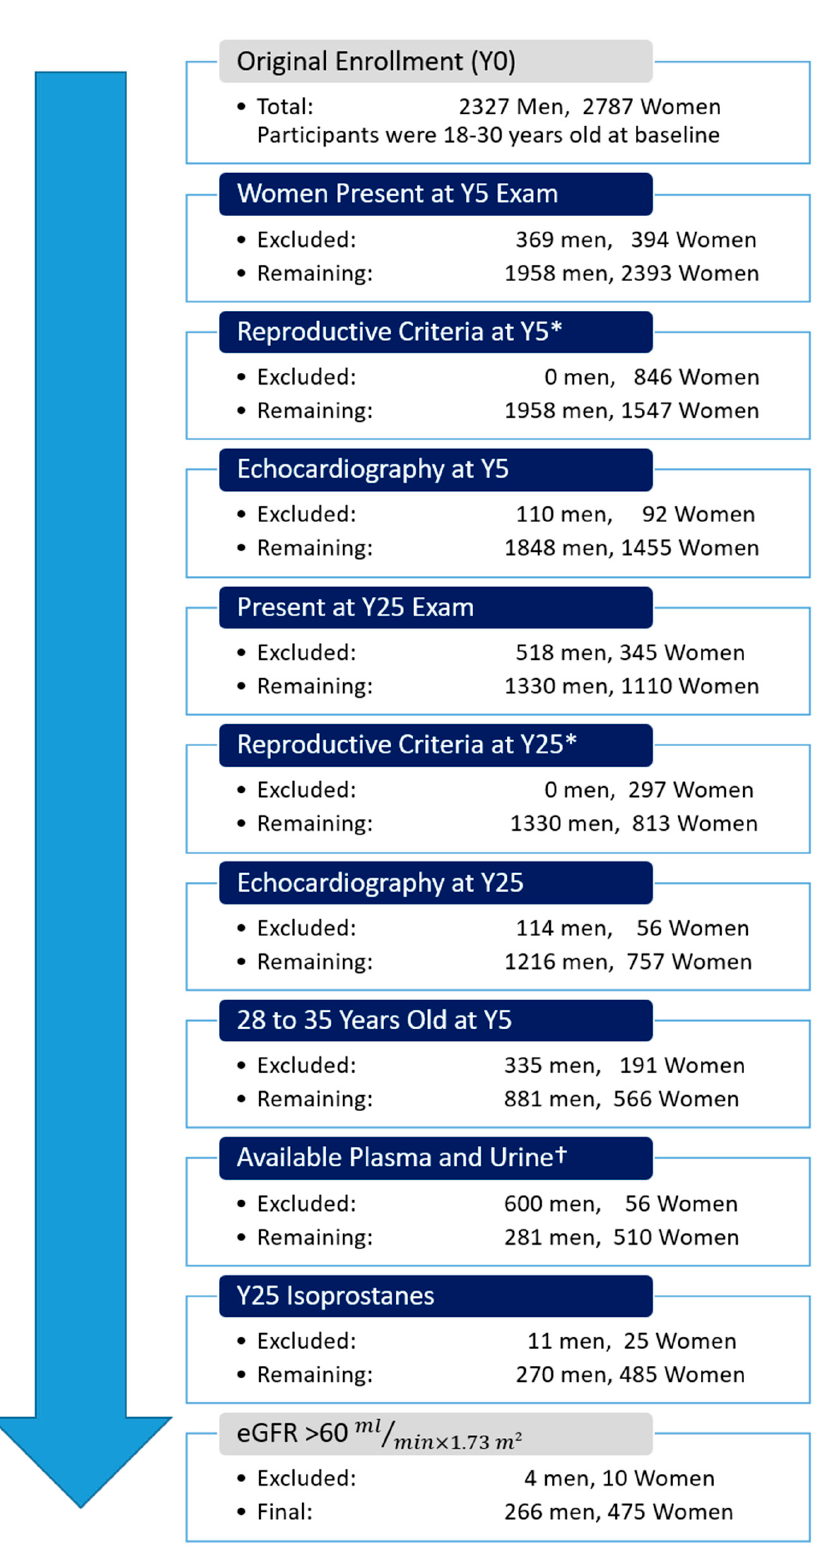
Figure 1. Inclusion/exclusion flow. * Reproductive criteria: known menopausal status and absence of pregnancy, breastfeeding or exogenous sex hormone use. † at both Y5 and Y25. Plasma-free (non-esterified) IsoP concentrations from the year 15 (Y15) exam were available from another prior CARDIA ancillary study [20] which comprised 2999